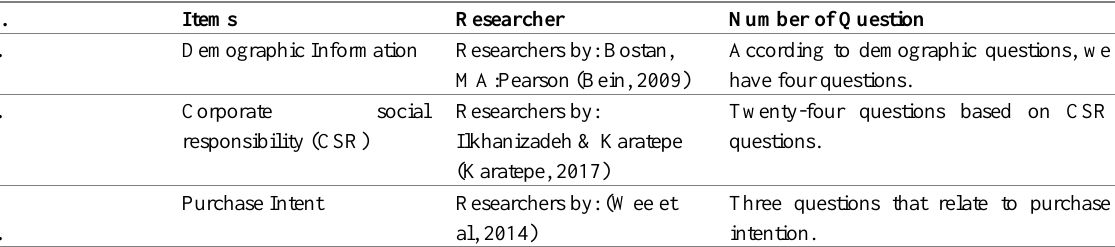
Table 3: Design of Questionnaires and References